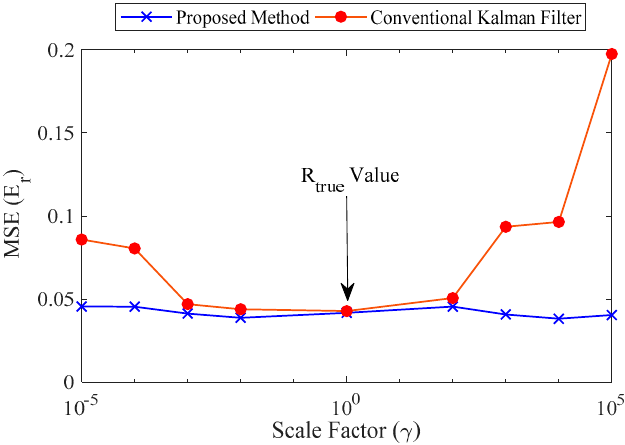
Figure 6. Comparison between the proposed method and a conventional Kalman filter